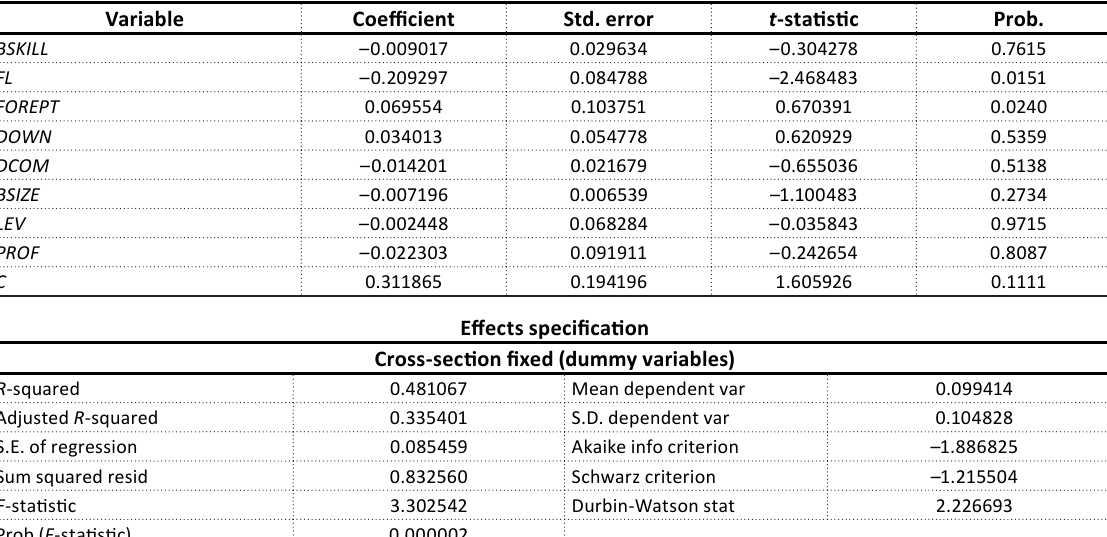
Source: Researcher’s computation